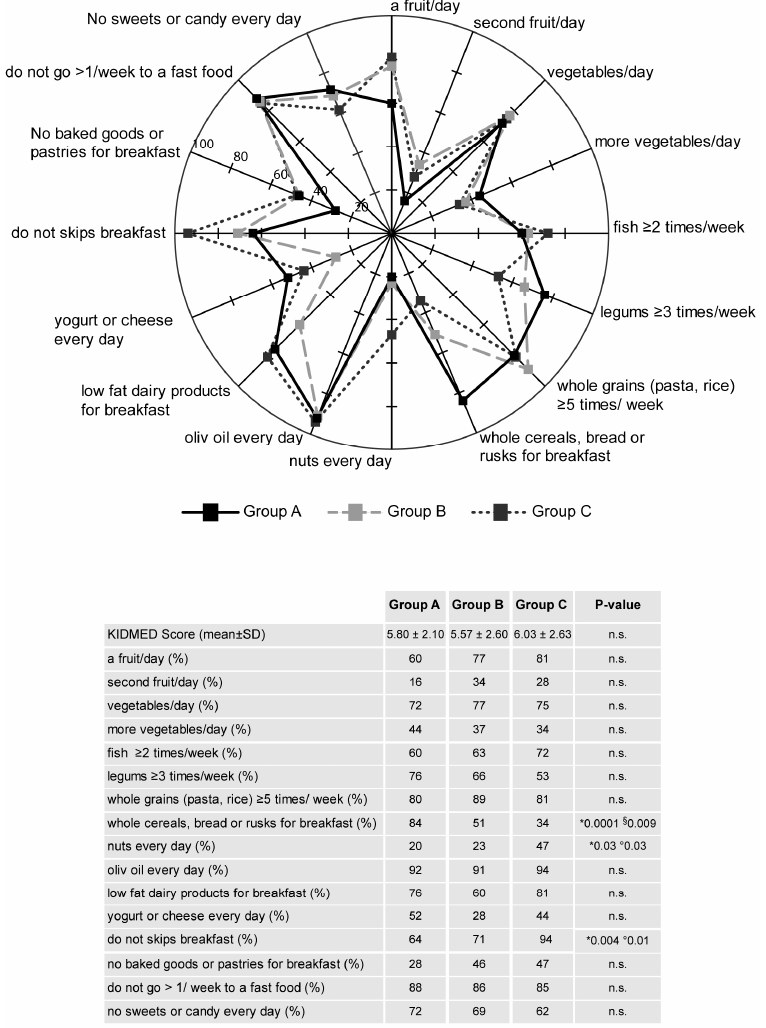
Figure 2. Compliance with items from the KIDMED test in the three physical activity groups (Group A, B and C). The radar chart plots the values of each item of Mediterranean diet score along a separate axis that starts in the center of the chart (0% compliance) and ends at the outer ring (100% compliance). The KIDMED score (M ± SD) and frequency (%) of the population adherence to each recommendation are reported in the table. Statistical differences were evaluated by Chi-squared tests. p < 0.05, * Group A vs. Group C; ◦ Group B vs. Group C; § Group A vs. Group